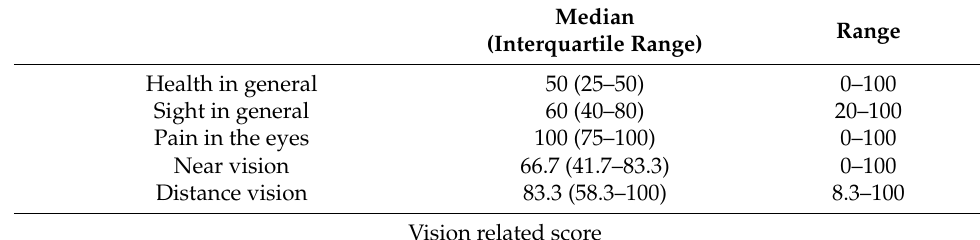
Table 3. Assessments of visual functioning (VFQ 25 questionnaire, ver. 2000).